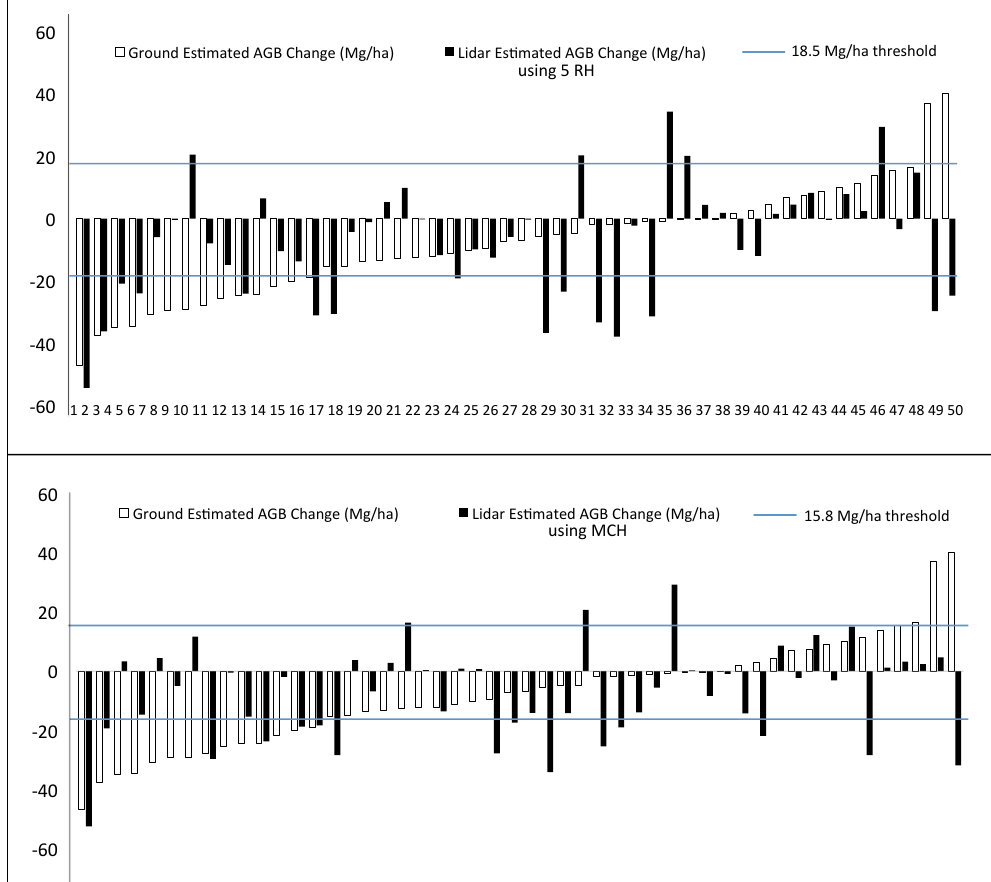
Fig. 6. Comparison of AGB change (ground estimation vs. lidar estimation) for every 1ha subplot using the 5RH approach (top) and the MCH approach (bottom). The sign of AGB change was correctly predicted for 30 and 32 of the 50 subplots.